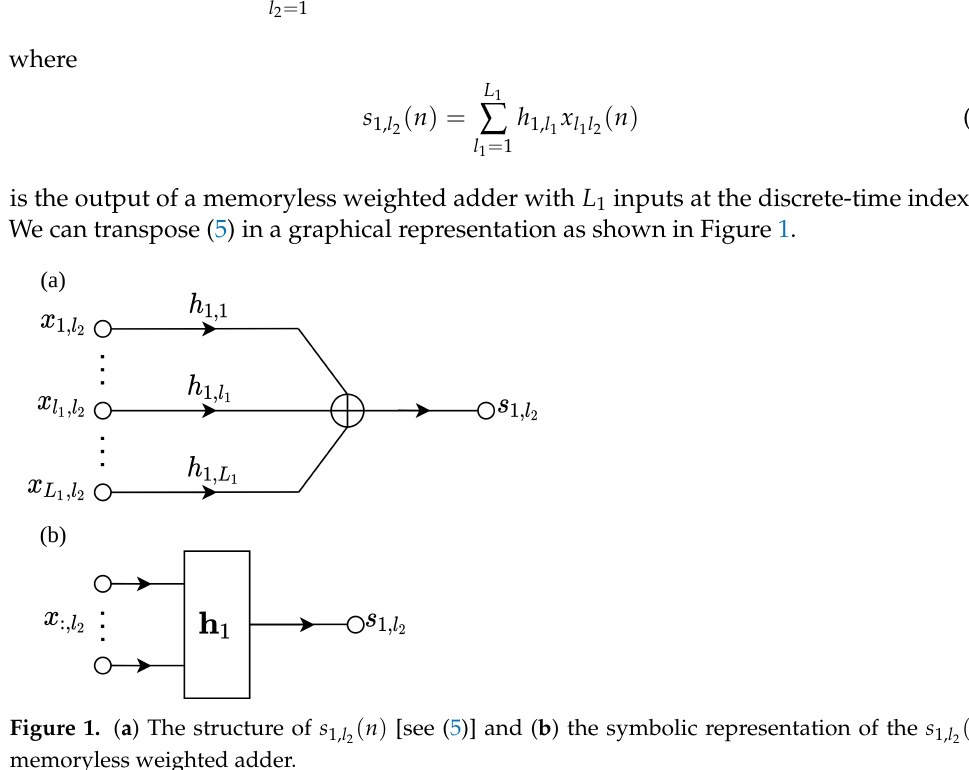
( n ) [see (5)] and ( b ) the symbolic representation of the s 2